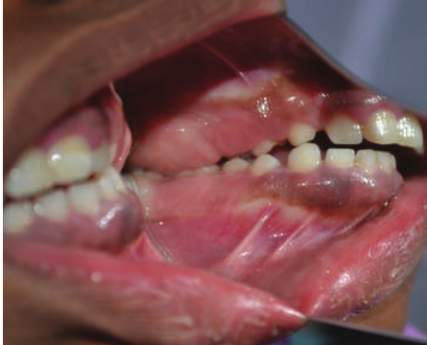
Figure 2: Clinical picture showing prominent enlargement in the posterior region.